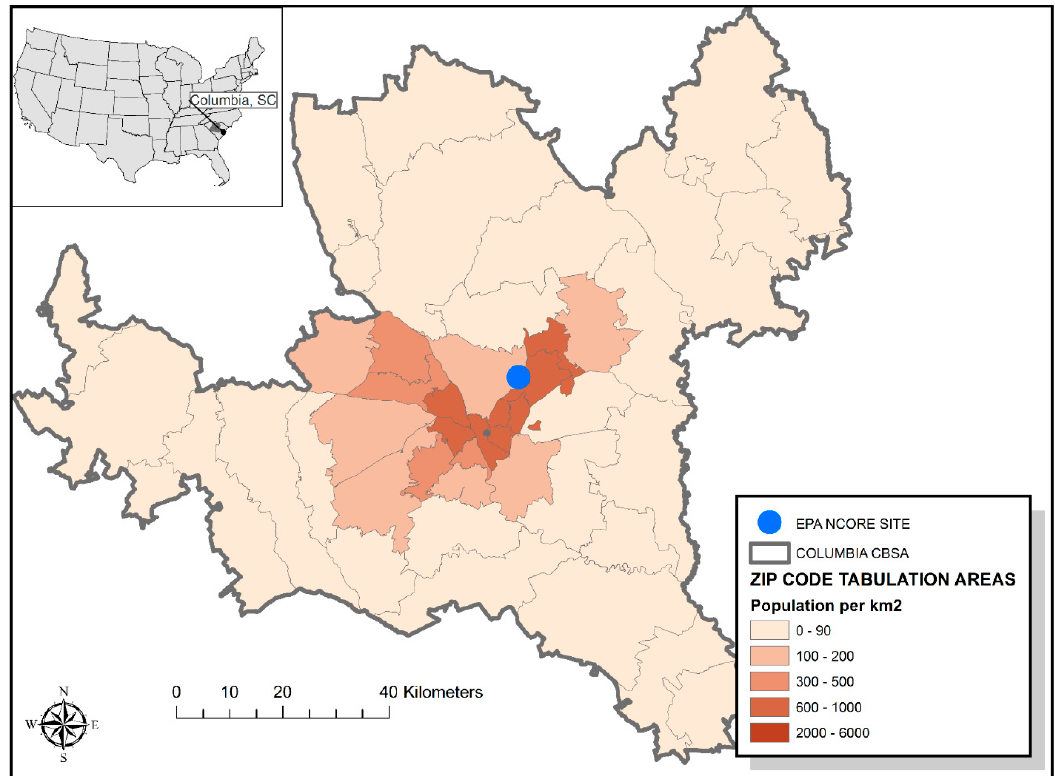
Figure 1. Map of study location depicting the study site within the Columbia core-based statistical area (CBSA). The CBSA represents an area with one or more counties anchored by an urban center of at least 10,000 people, together with adjacent counties that are socioeconomically associated with the urban center.